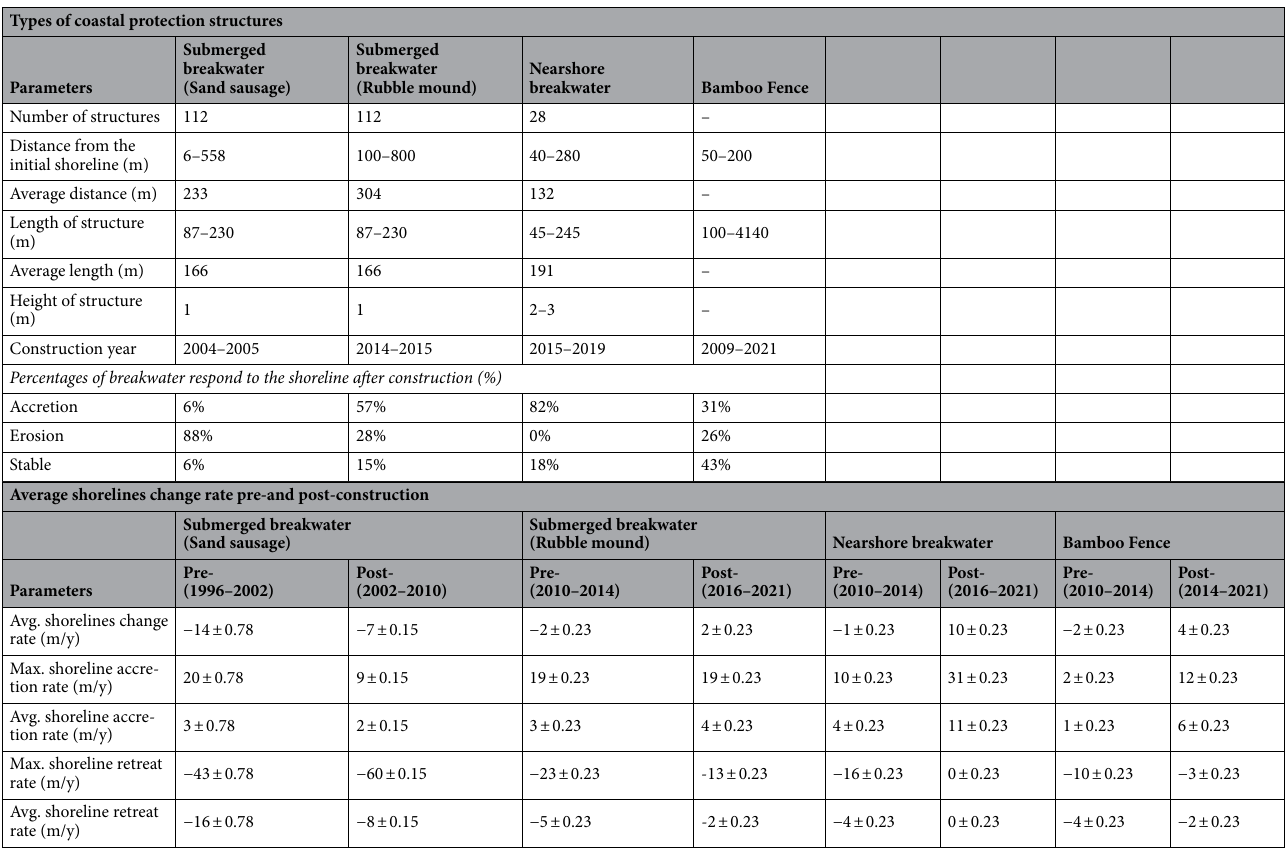
Table 2. Summary of coastal structure details and the average shoreline change rate pre-and post- construction. Avg. = average; Max. =